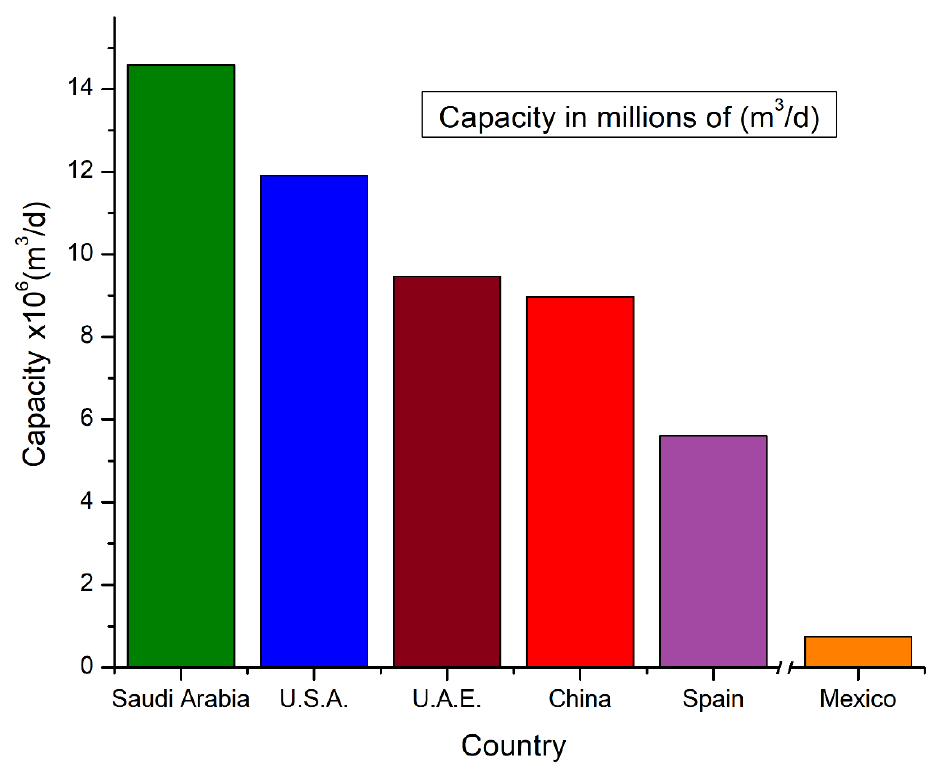
Figure 2. Comparison between the countries with the largest desalination capacity and Mexico [8].